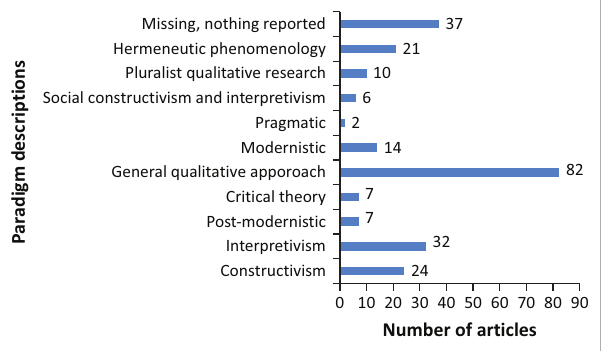
FIGURE 2: The different paradigm descriptions featuring in the total sample of articles ( n =